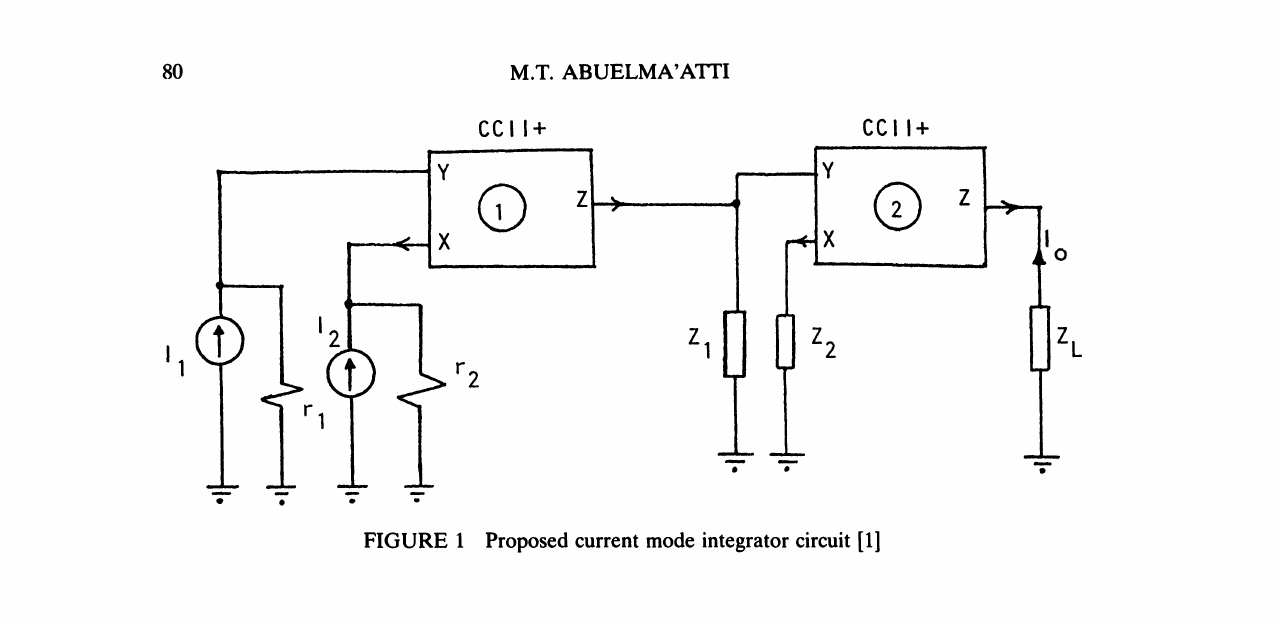
FIGURE Proposed current mode integrator circuit [1]